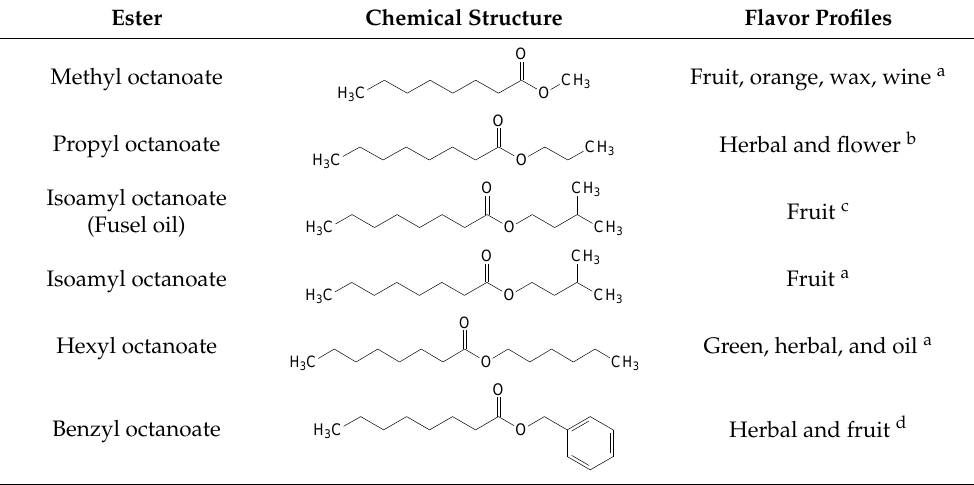
Table 1. Technical information of the different flavor esters from octanoic acid produced in this study. Ester